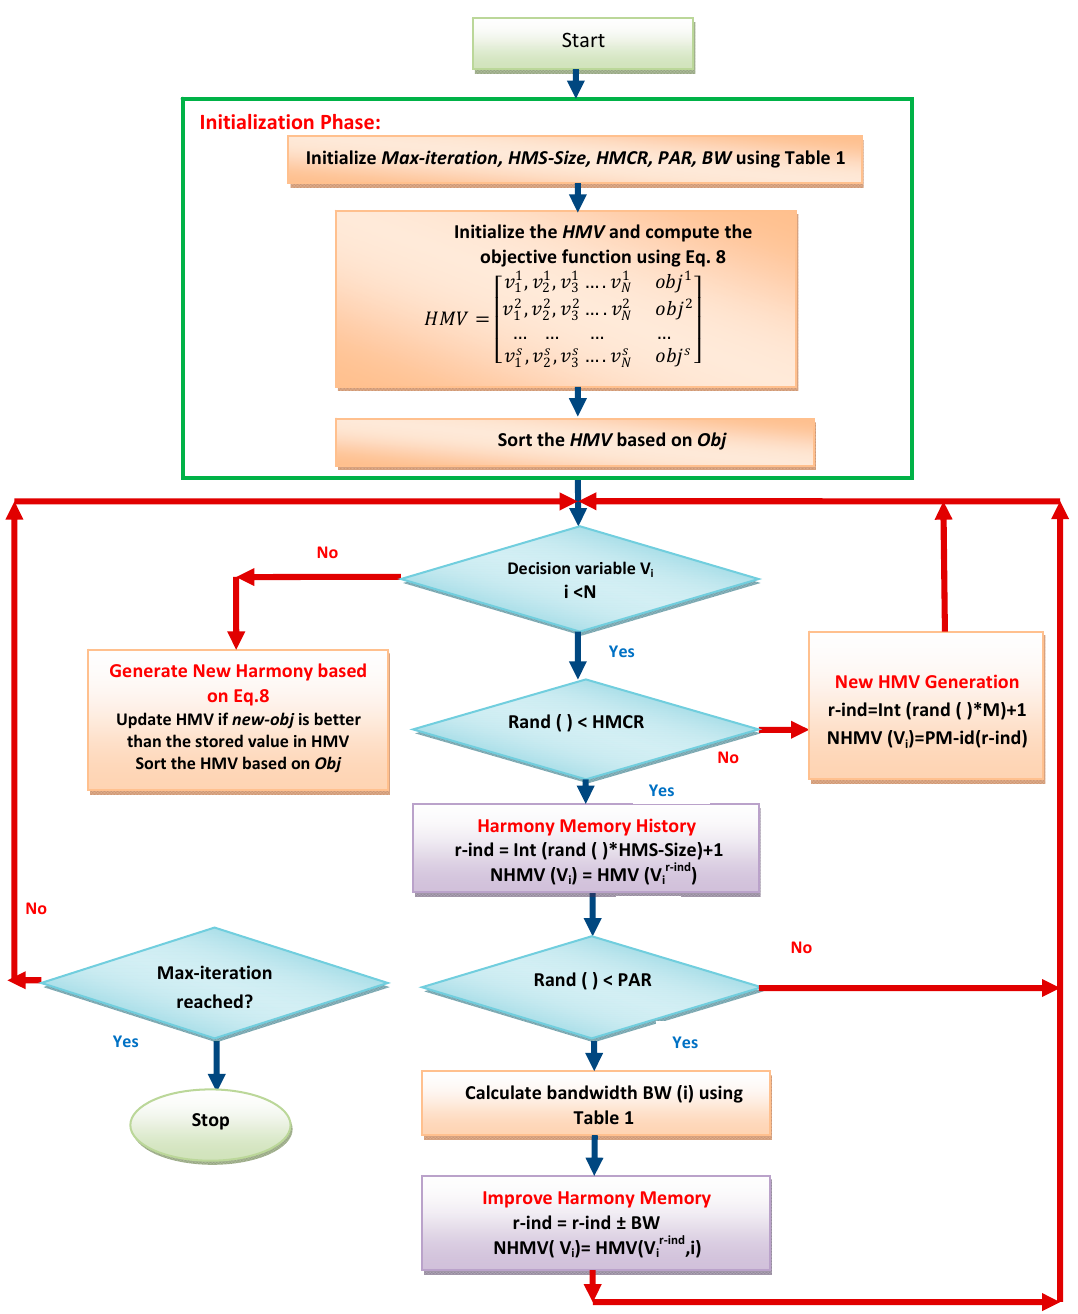
Figure 2. AHSA based power optimization procedure.